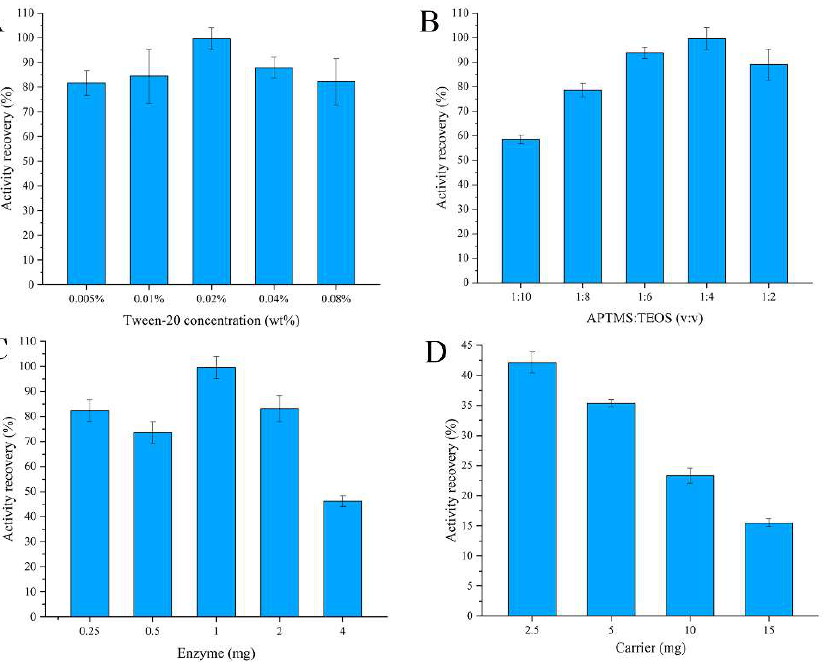
Figure 2. Effect of the preparation of encapsulated glucose oxidase: ( A ) concentration of Tween-20; ( B ) ratio of APTMS and TEOS; ( C ) amount of enzyme; ( D ) amount of carrier.